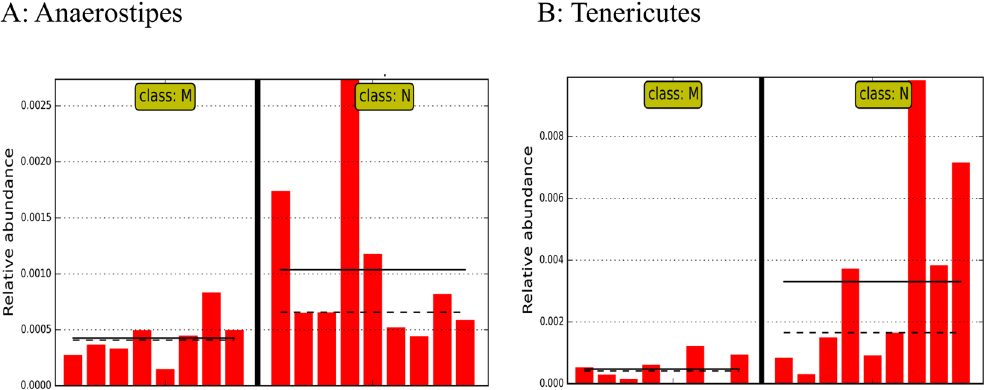
Figure 5. Microbial taxa displaying significant differences in relative abundance between healthy and exhaustive exercise induced stressed mice. ( A ) Anaerostipes. ( B ) Tenericutes. N: healthy mice + PBS; M: mice subjected to exhaustive exercise stress + PBS. Straight line: group mean abundance. Dotted Line: median.